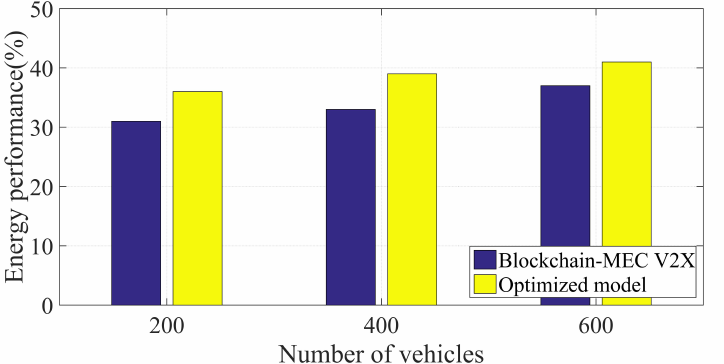
Figure 8. Energy performance of the developed systems compared with the traditional systems, for different values of deployed